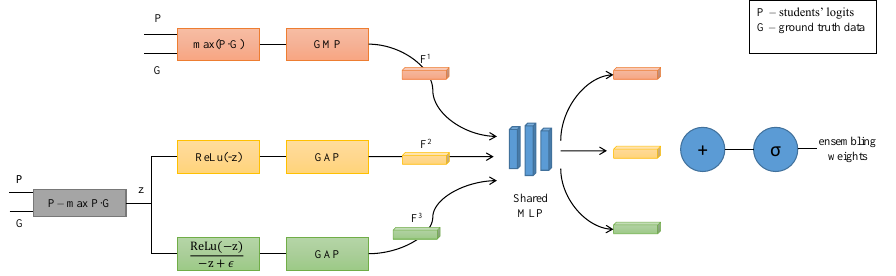
Figure 2. Ensembling strategy. The logits of the peer networks are assembled by an attention mechanism. P are the stacked logits of the sub-networks, and G represents the one-hot encoded ground truth data. Three features ( F 1 , F 2 , and F 3 ) are computed and then passed through a multi-layer perceptron to compute the assembling weights of the